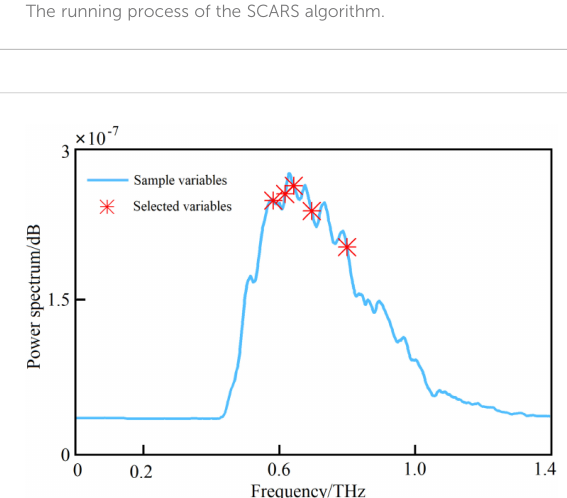
FIGURE 9 The running process of the SCARS algorithm.